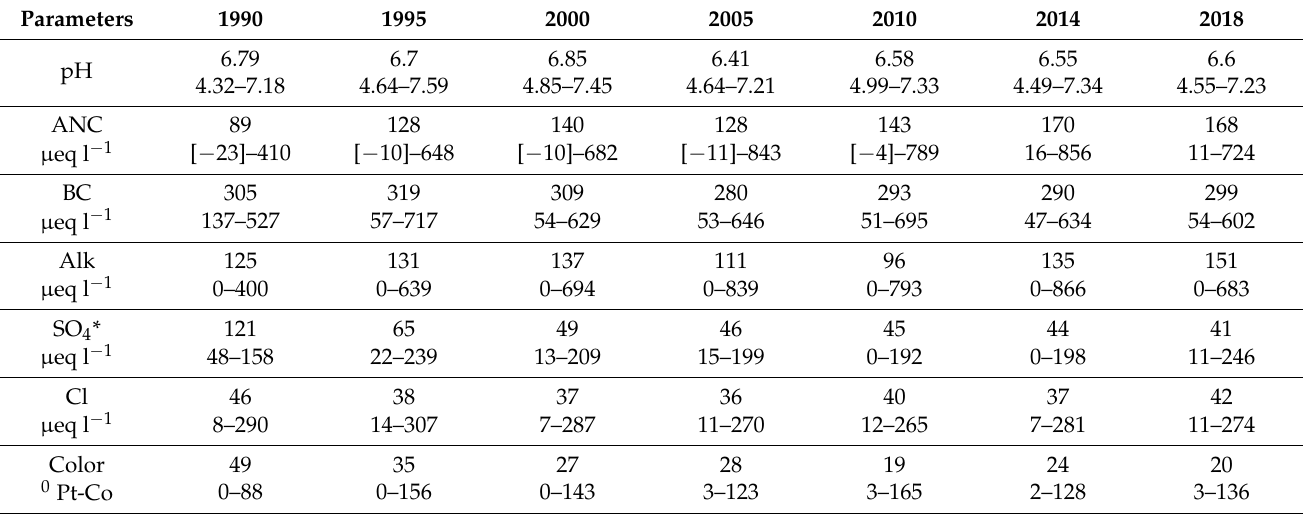
Table 2. Median and limits of variation of water chemistry parameters of the water bodies for a 28-year period (1990–2018) of the Kola